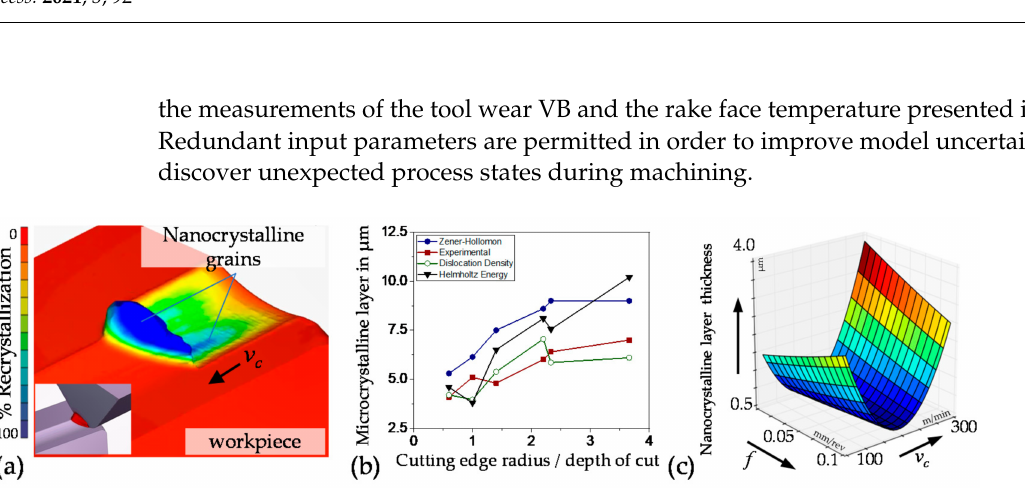
Figure 11. Nanocrystalline layer formation simulation ( a ) 3D-FE Simulation example; ( b ) Comparison of microcrystalline layer thickness experimentally measured using focused ion beam and simulated using three different material models; ( c ) Simulated nanocrystalline layer thickness with process parameters